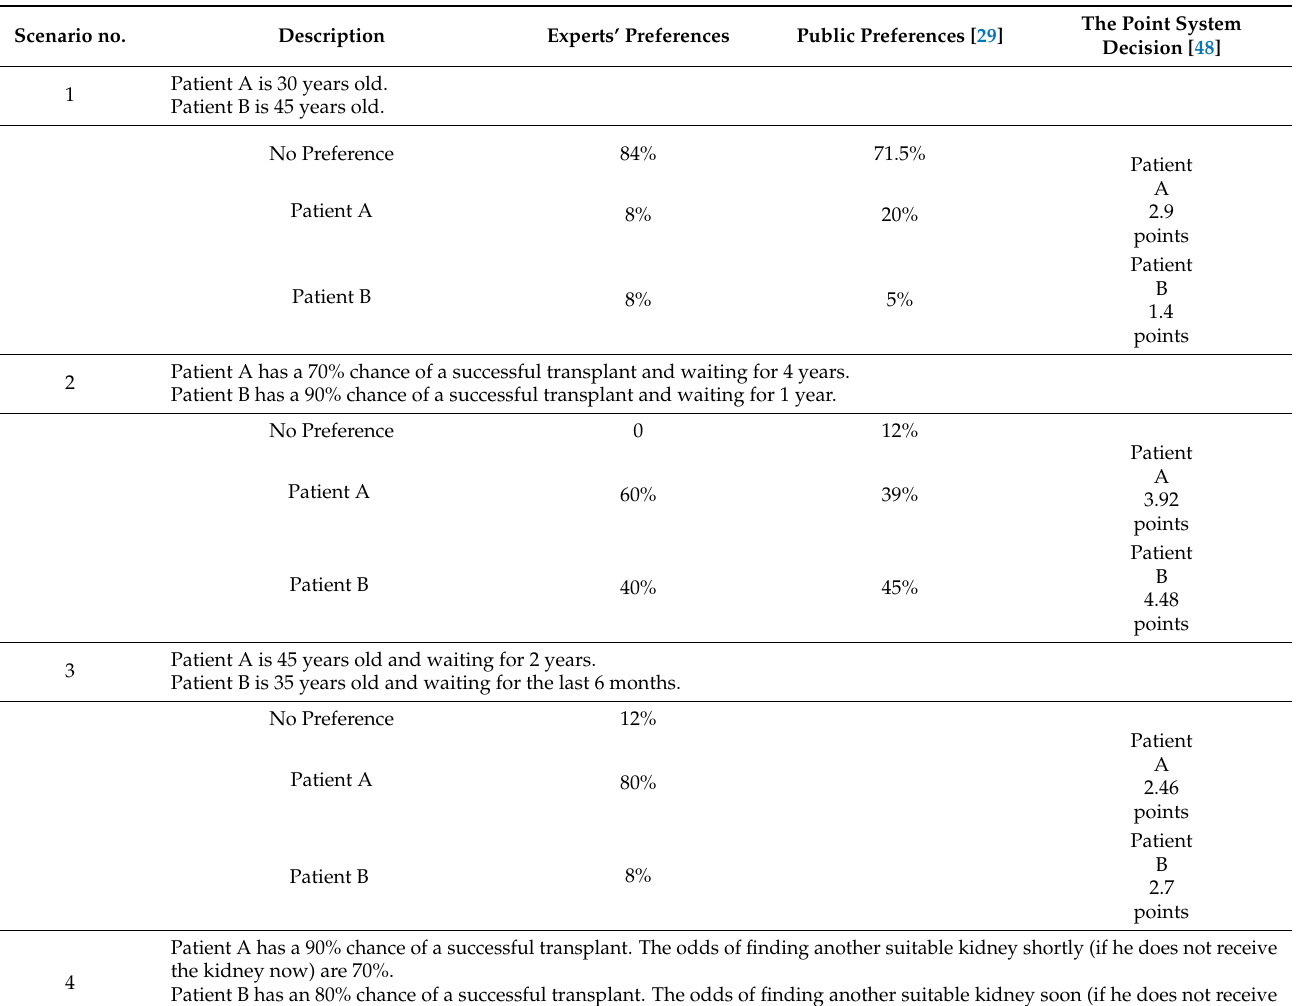
Table 6. Comparison of medical experts’ preferences, reported public preferences, and Israeli National Transplant Center’s point